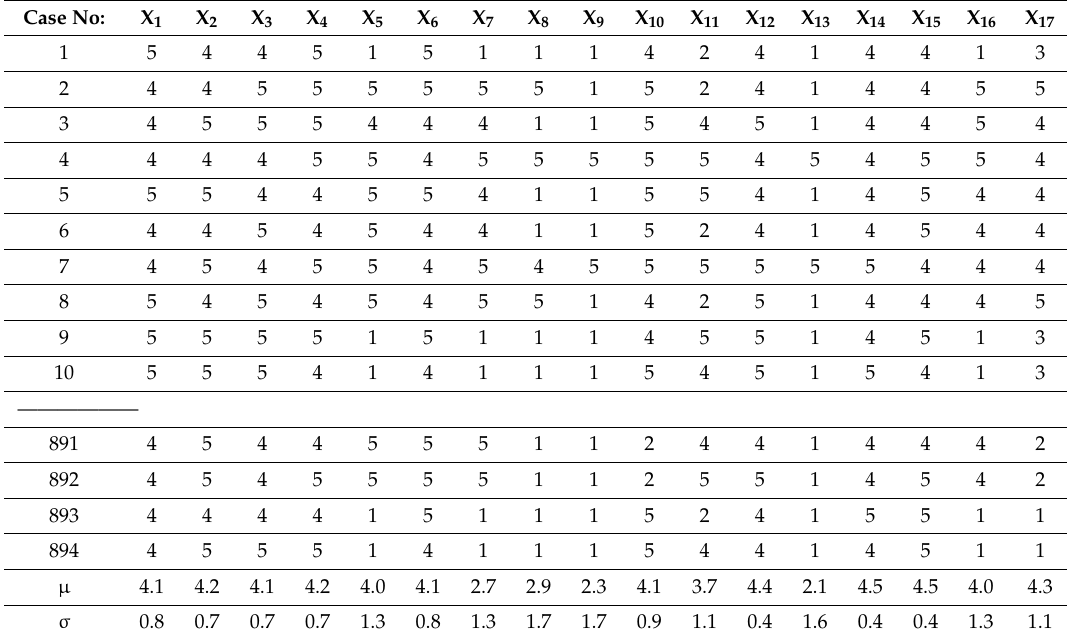
Table 4. Tested data from the accident